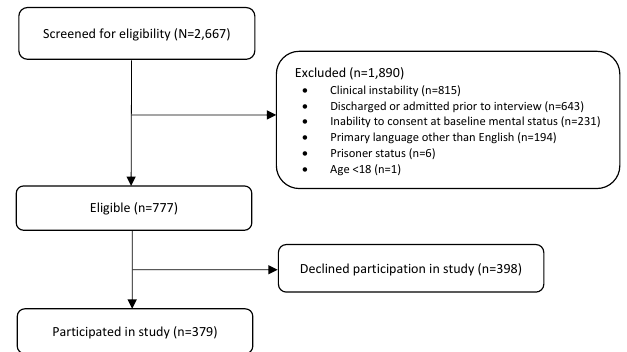
Figure 1. Participant enrollment in intra-pandemic study.